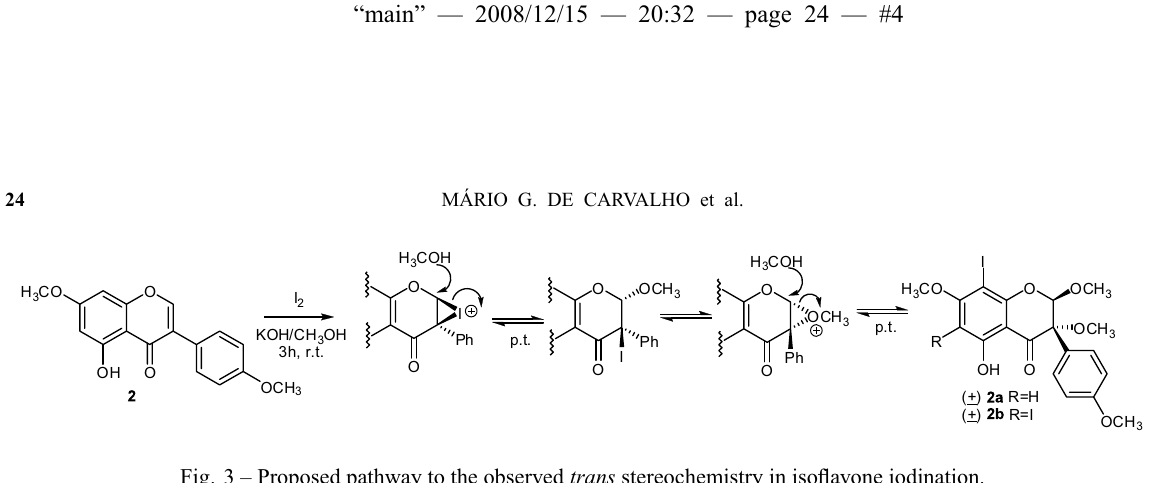
Fig. 3 – Proposed pathway to the observed trans stereochemistry in isoflavone iodination.